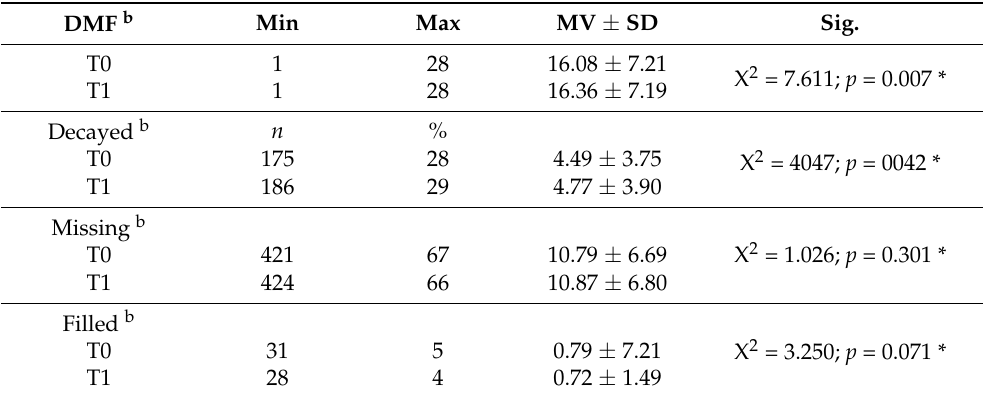
Table 5. Descriptive and comparative analysis of the Decayed, Missing, and Filled Teeth Index and its individual parameters, between assessment moments. DMF b Min Max MV ± SD